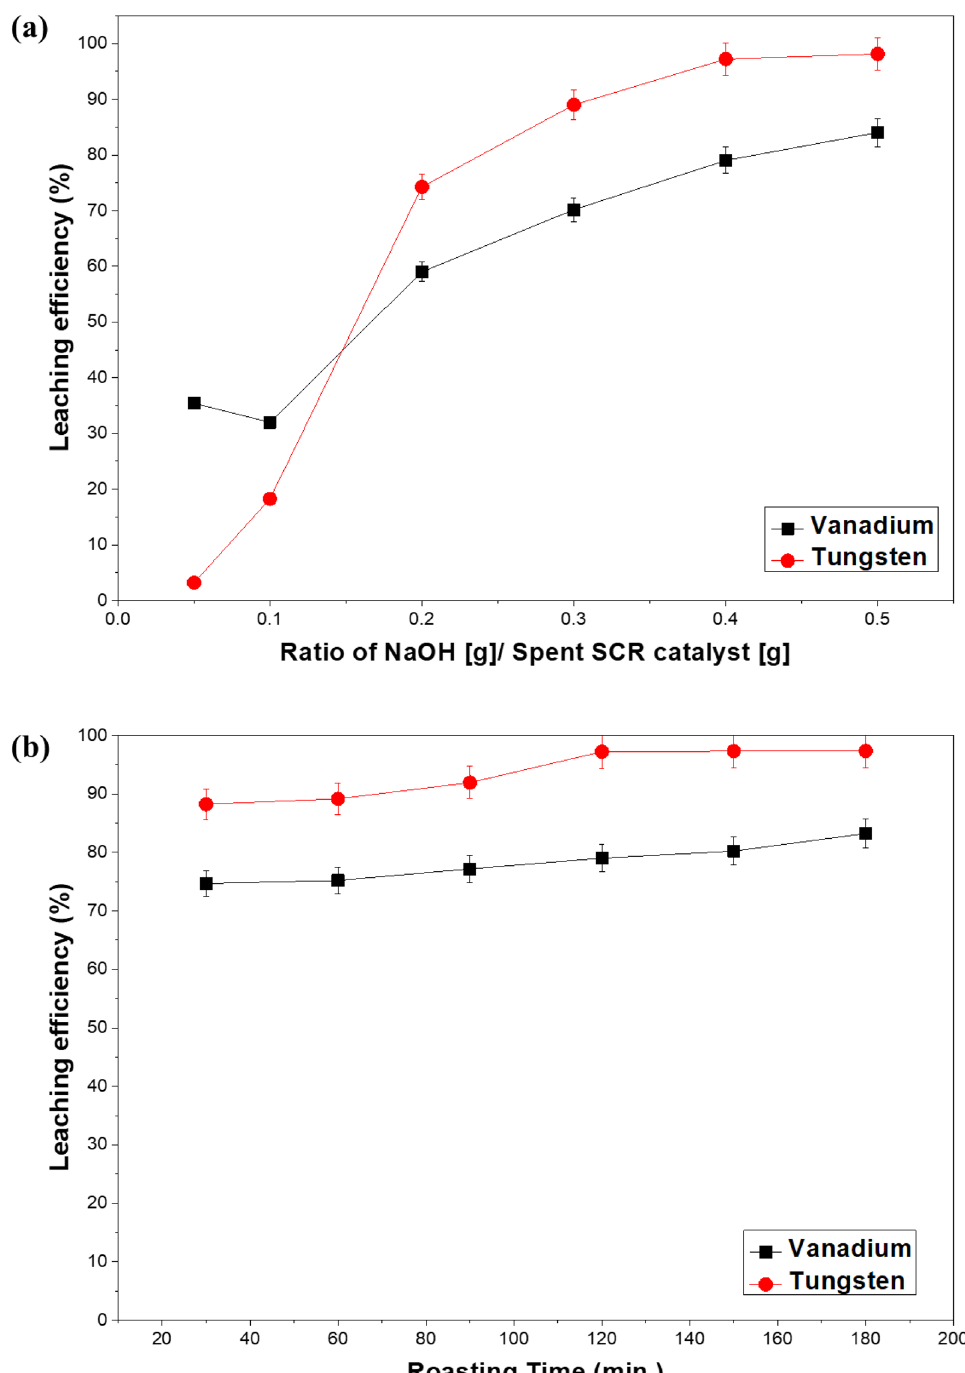
Figure 2. Effect of sodium hydroxide ammount and time for roasting